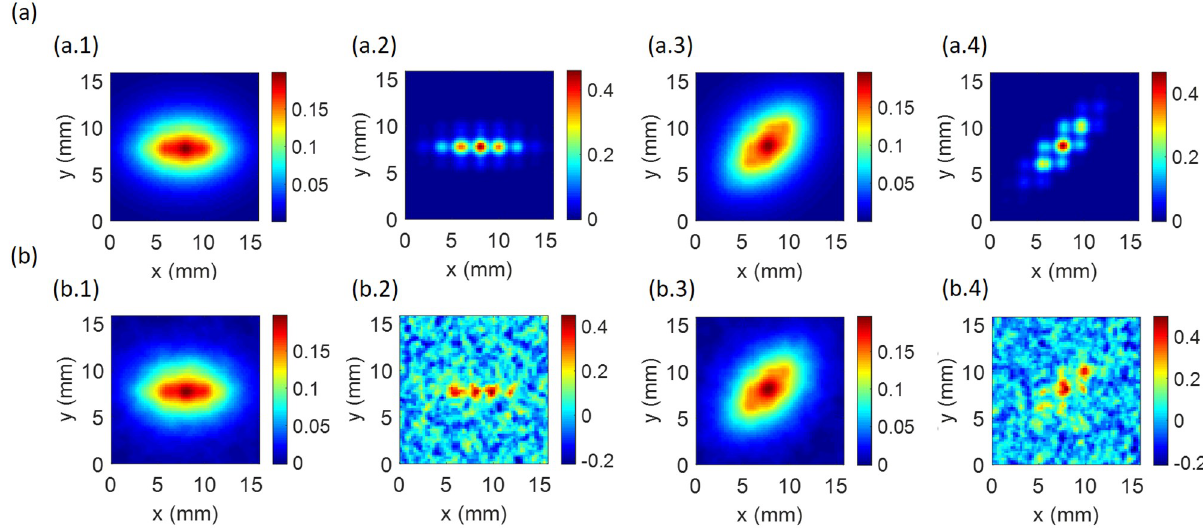
Fig 7. Deconvolution to recover neural activity. (a) Deconvolution method without noise. (a.1) BOLD-Wiener with σ of 0.06 for OP of 0˚. (a.2) Deconvolved neural activity from panel a.1. (a.3) BOLD-Wiener with σ of 0.06 for OP of 45˚. (a.4) Deconvolved neural activity from panel a.3. (b) Deconvolution to recover neural activity with white noise. White noise varies with voxel volume (as described in Sec. Simulated data). (b.1) Noisy BOLD-Wiener for OP of 0˚. (b.2) Deconvolved neural activity from panel b.1. (b.3) Noisy BOLD-Wiener for OP of 45˚. (b.4) Deconvolved neural activity from panel b.3. For all panels, the resolution used is 0.25